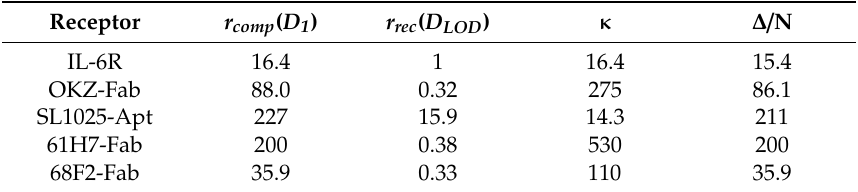
Table 3. Resistance data for the set of analyzed complexes. The resistances of the complex and the receptor, calculated in the ideal conditions of maximum response, r comp ( D 1 ), and the limit of detection (LOD), r rec ( D LOD ), normalized to the value of r rec ( D LOD ) of IL-6R, are reported as well as the corresponding receptor increment ∆ , and ratio κ